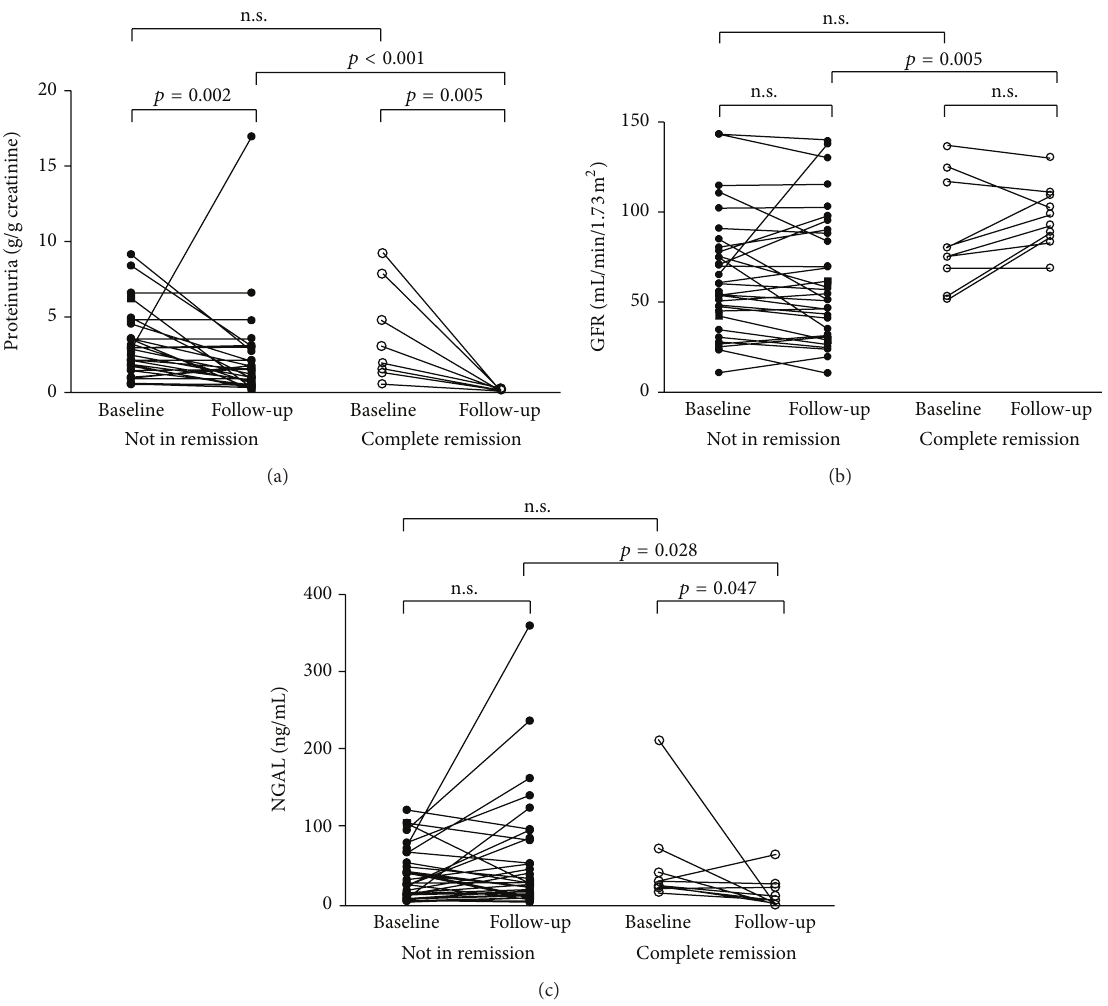
Figure 3: Laboratory parameters according to remission status at follow-up. (a) Proteinuria, (b) glomerular filtration rate, and (c) NGAL at baseline and follow-up. Complete remission ( 𝑛 = 10 ); not in remission ( 𝑛 = 33 ).